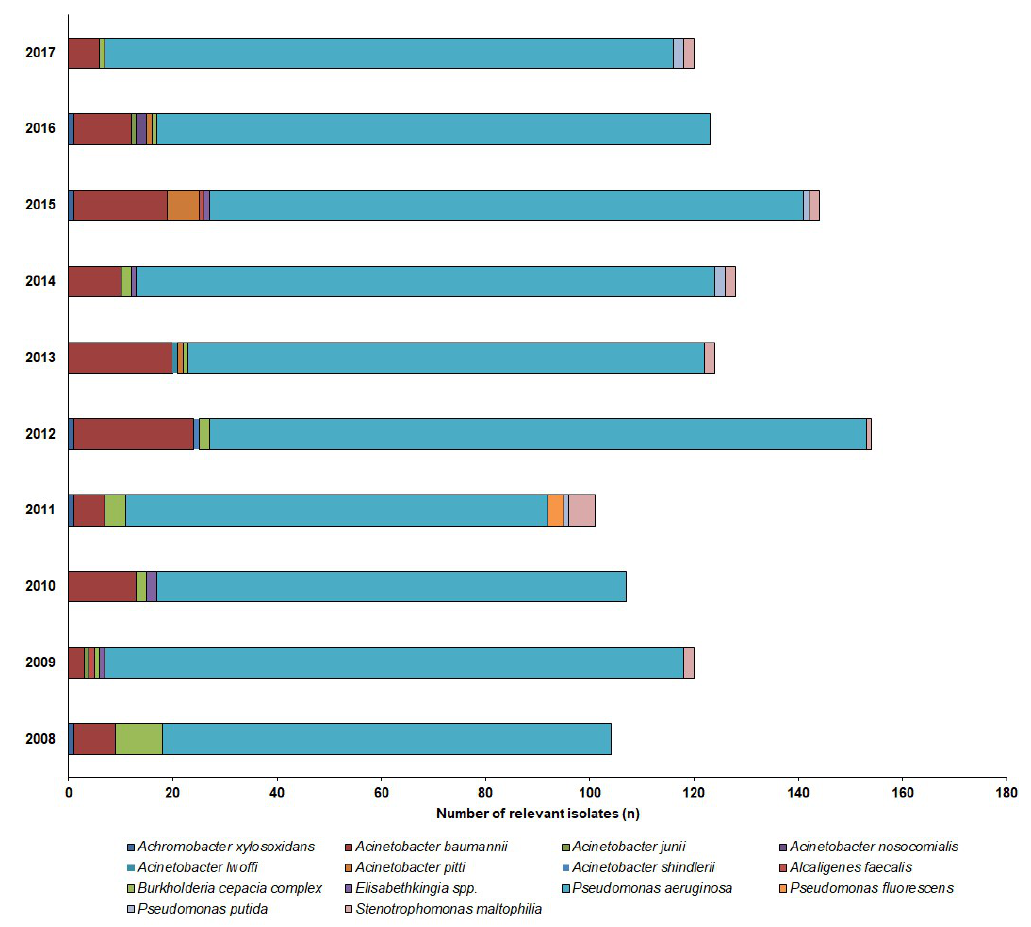
Figure 2. Frequency and species distribution of non-fermenting Gram-negative bacterial (NFGNB) isolates in the outpatient samples (2008—2017).